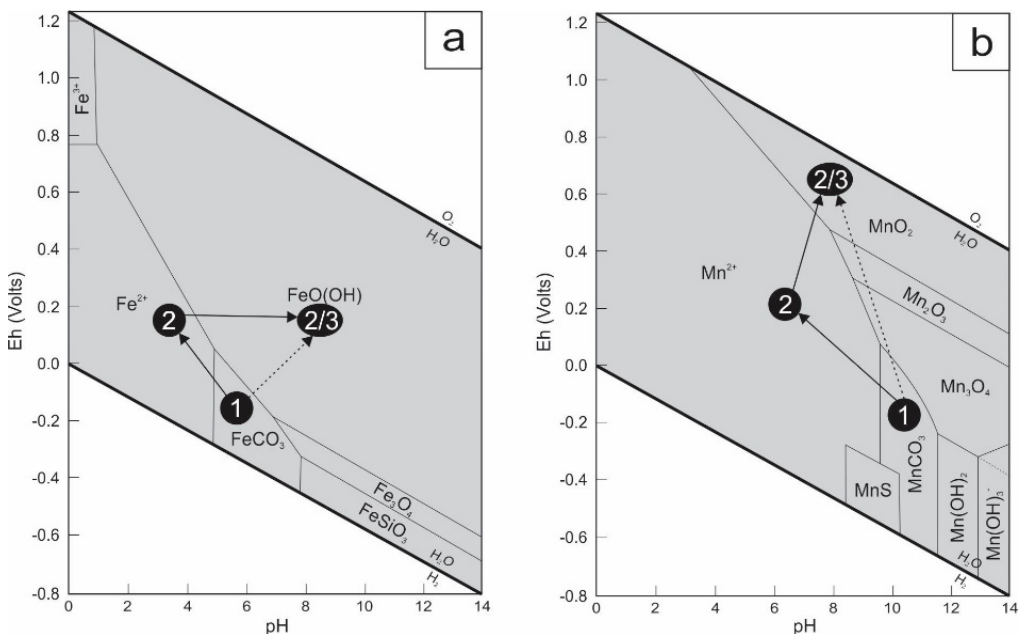
Figure 7. ( a ) Eh–pH diagram for a part of the Fe-C-Si-O-H system, showing the stability fields of selected iron minerals at 25 °C and 1 atmosphere (modified after [47]). Siderite (1) may be directly weathered in goethite (2), or it may be leached first, leading to the presence of aqueous Fe 2+ (2) and later to the precipitation of goethite (3); ( b ) Eh–pH diagram for a part of the Mn-C-S-O-H system showing the stability fields of selected manganese minerals at 25 °C and 1 atmosphere (modified after [47]). Rhodochrosite may be directly weathered in pyrolusite (2), or is firstly leached, leading to the presence of aqueous Mn 2+ (2) and later to the precipitation of pyrolusite (3).